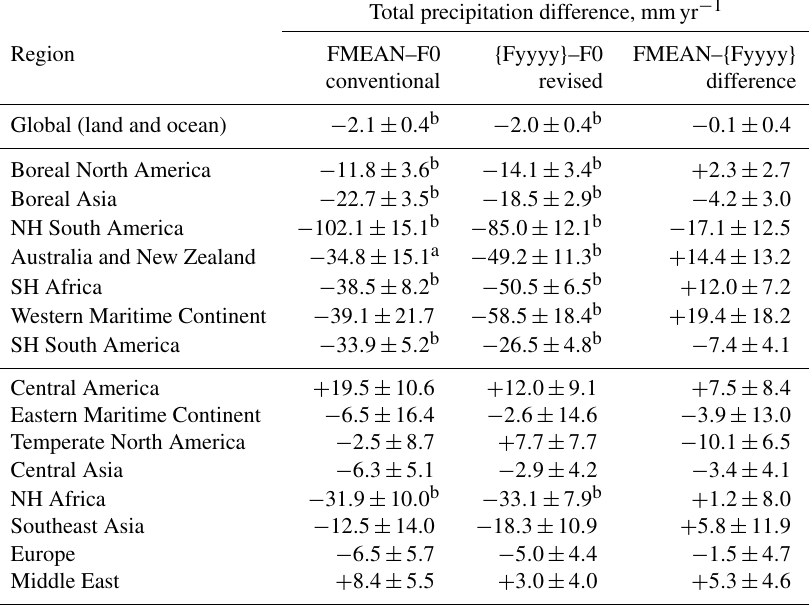
Table 3. Total (large-scale plus convective) annual precipitation differences for different simulation combinations and regions. Combined standard errors have been calculated. Significance has been tested using Welch’s t test: a indicates differences that are statistically significant at two-tailed p < 0 . 05, and b indicates differences that are statistically significant at two-tailed p < 0 .